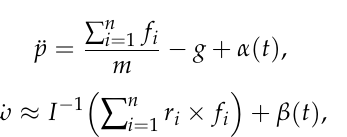
R is the rotation b